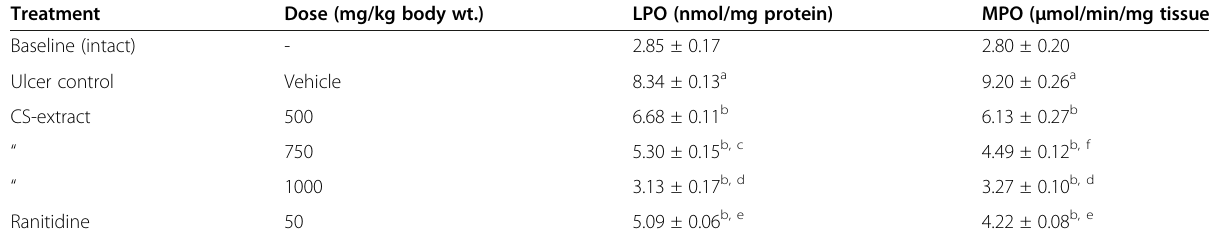
a p< 0.001 compared with baseline; b p< 0.001 compared with ulcer control; c p< 0.001 compared with CS-500; d p< 0.001 compared with CS-750; e p< 0.001 compared with CS-1000; f p< 0.05 compared with CS-500; Values are Mean ± SEM of 6 animals. Statistical significance was determined by one-way analysis of variance (ANOVA) followed by Dunnett ’ s post hoc t test.